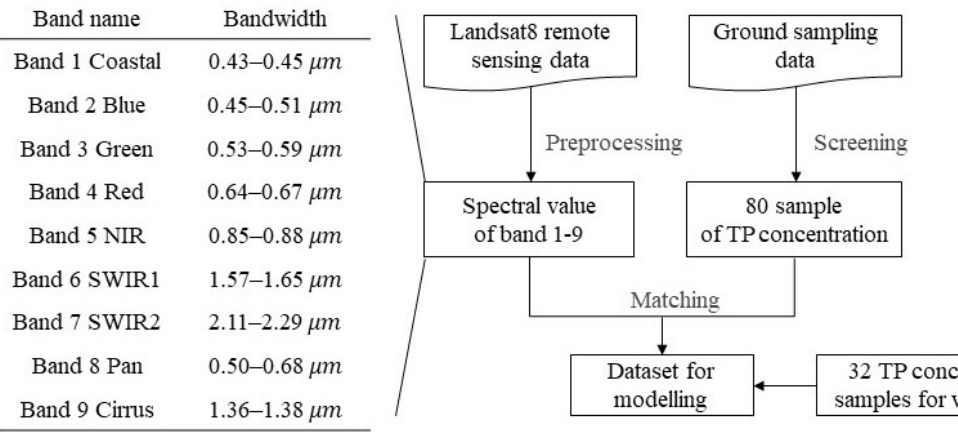
Figure 2. Flow chart of data set preparation for modeling.